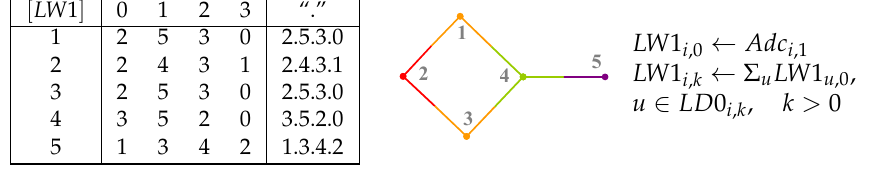
Figure 12. [ LW 1 ] on Figure